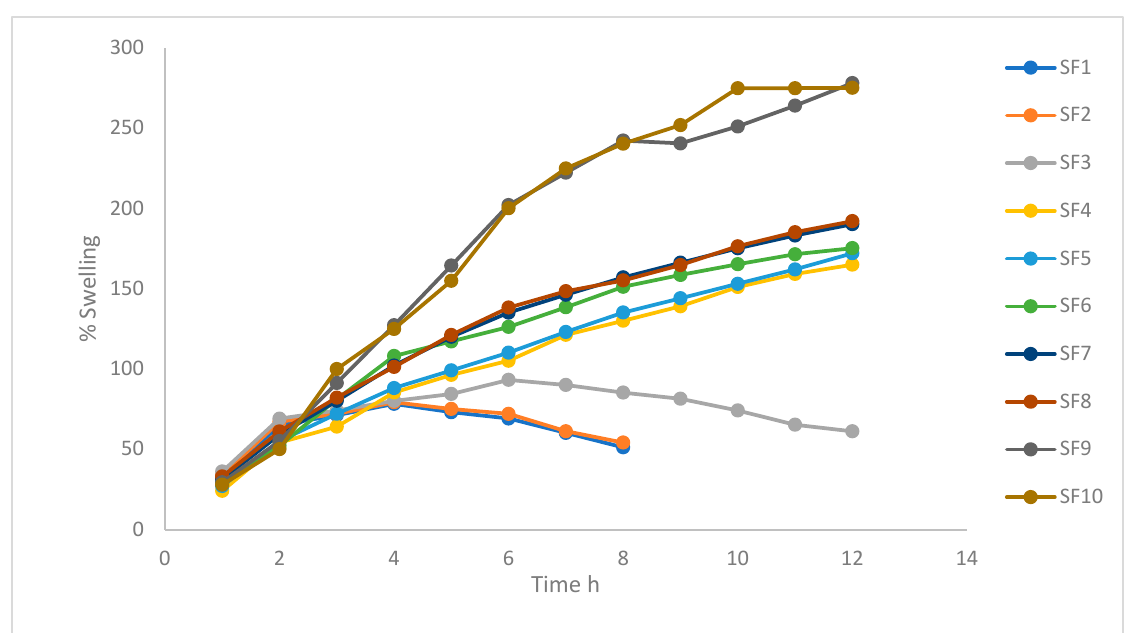
Figure 3. Formulations’ presented swelling index.